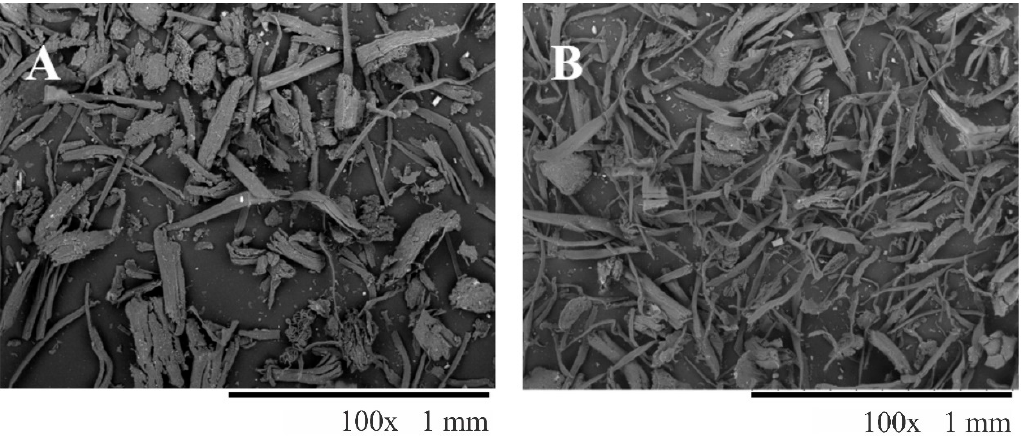
Figure 1. SEM micrographs of agave fibers (AF) used for biocomposite preparation ( A ) after sieving, and ( B ) after high shear mixing process (100× magnification).